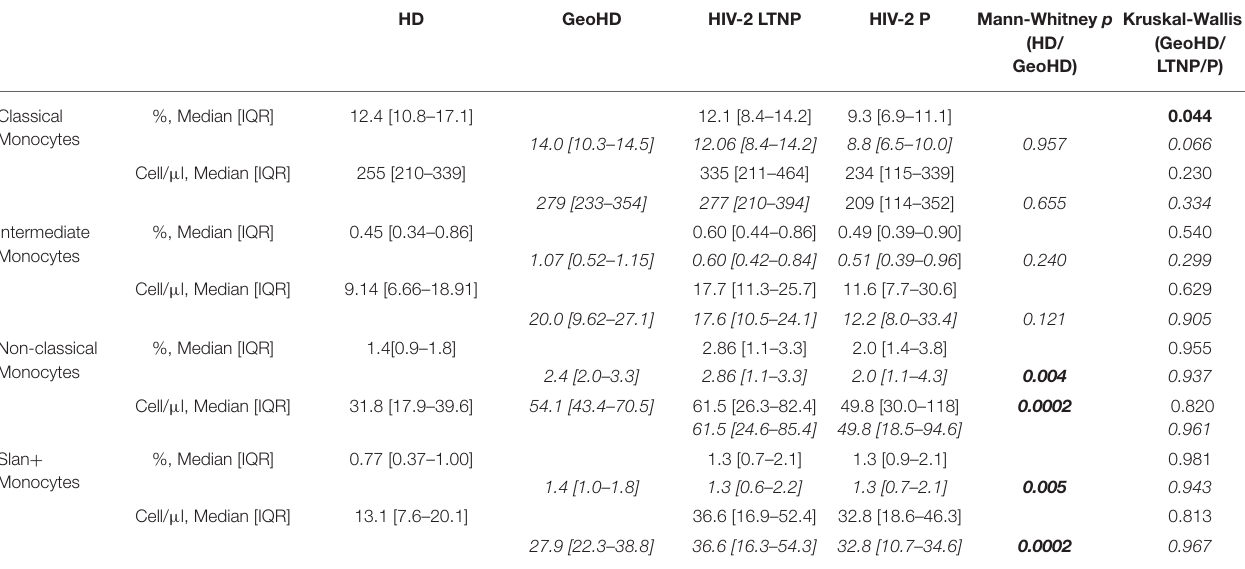
TABLE 2 | Monocyte subset percentages among CD45 + PBMC and absolute counts in HIV-2- infected and uninfected